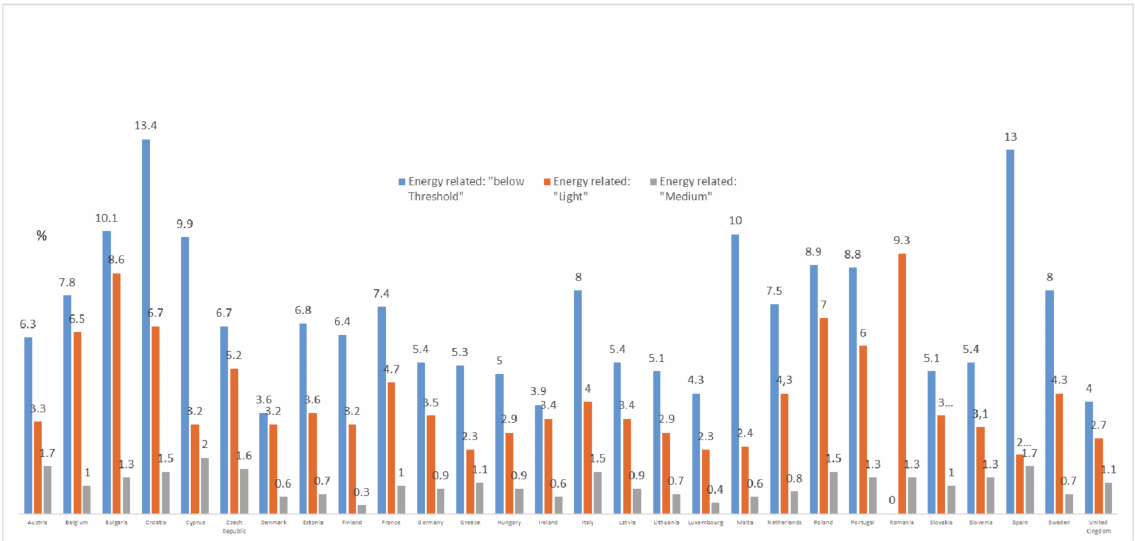
Figure 1. Energy renovation in residential buildings by its rate as a percentage [32] (Source: European court of audits,